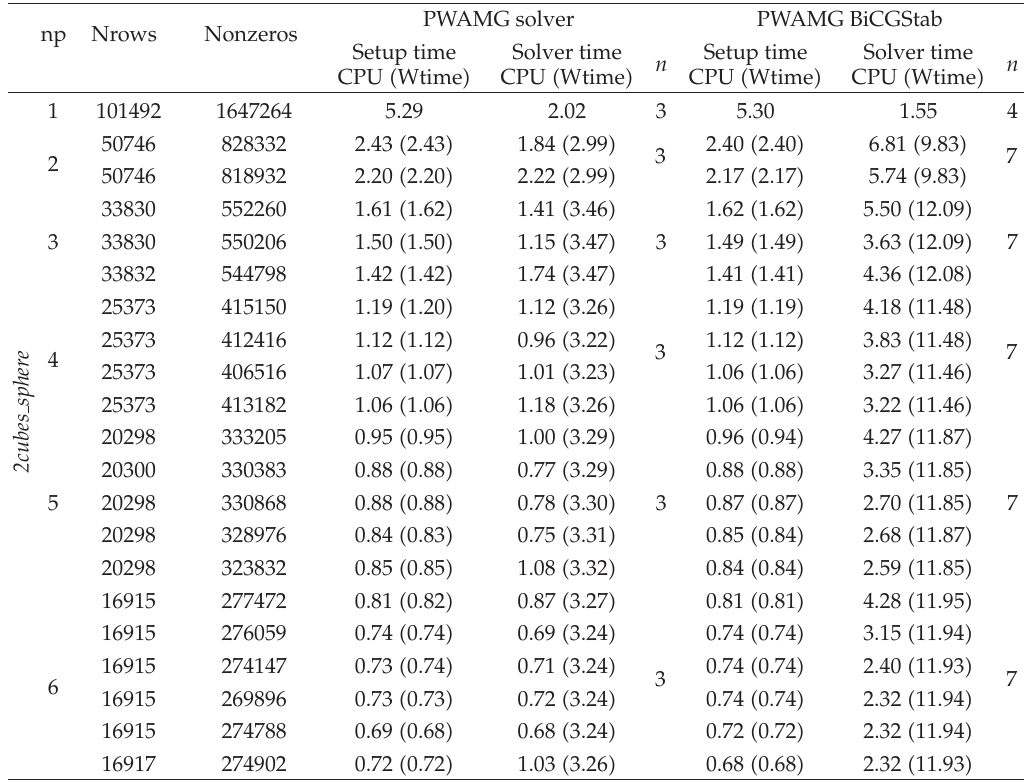
Table 3: Parallel results for 2cubes sphere